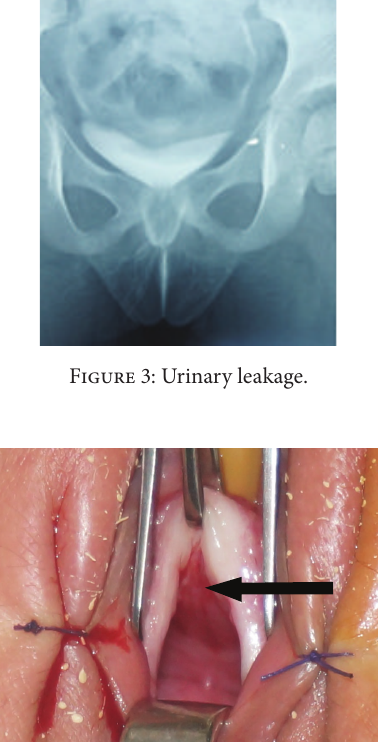
Figure 4: Urethrovaginal fistula difficult to